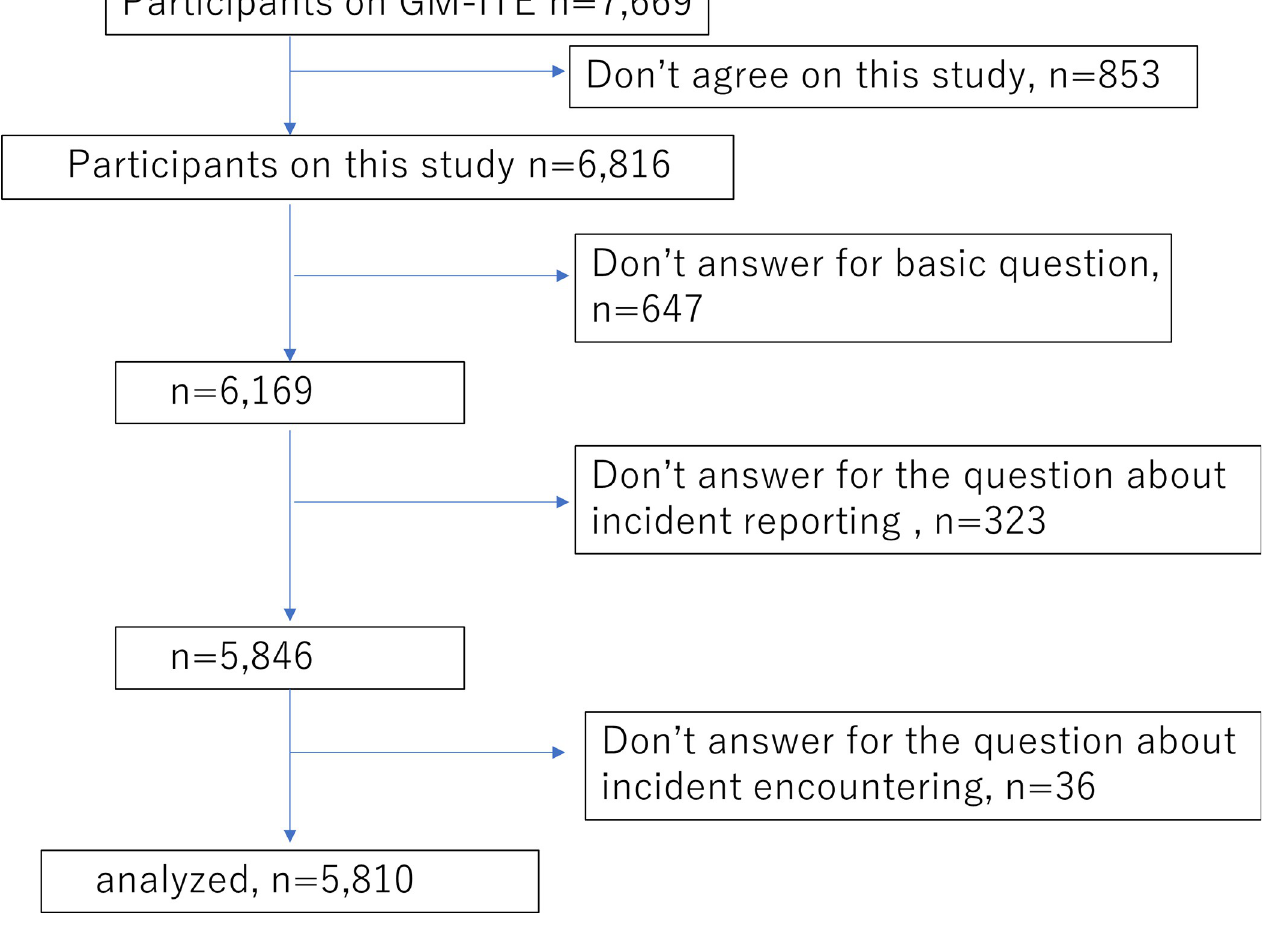
Fig 1. Flowchart of survey